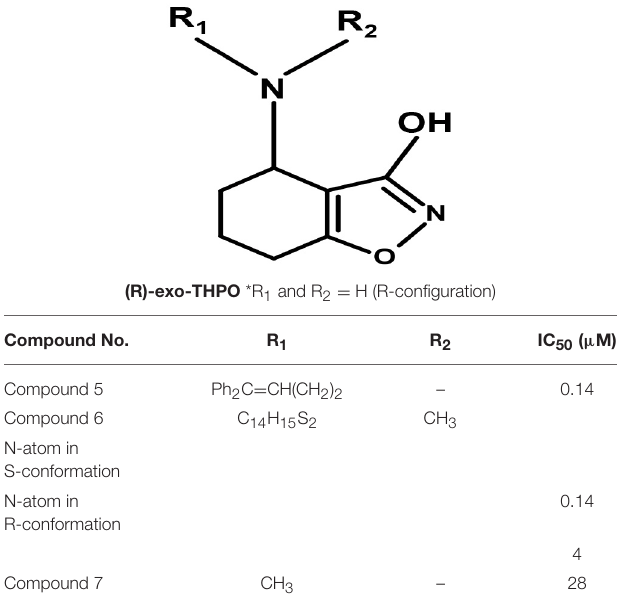
( Table 3 ) (Clausen et al., 2005b). Additionally, N -methyl- exo-THPO with binding affinity of 28 µ M acted as astrocytic GABA transport blocker ( Table 3 , compound 7) (Yang and Rothstein, 2009).